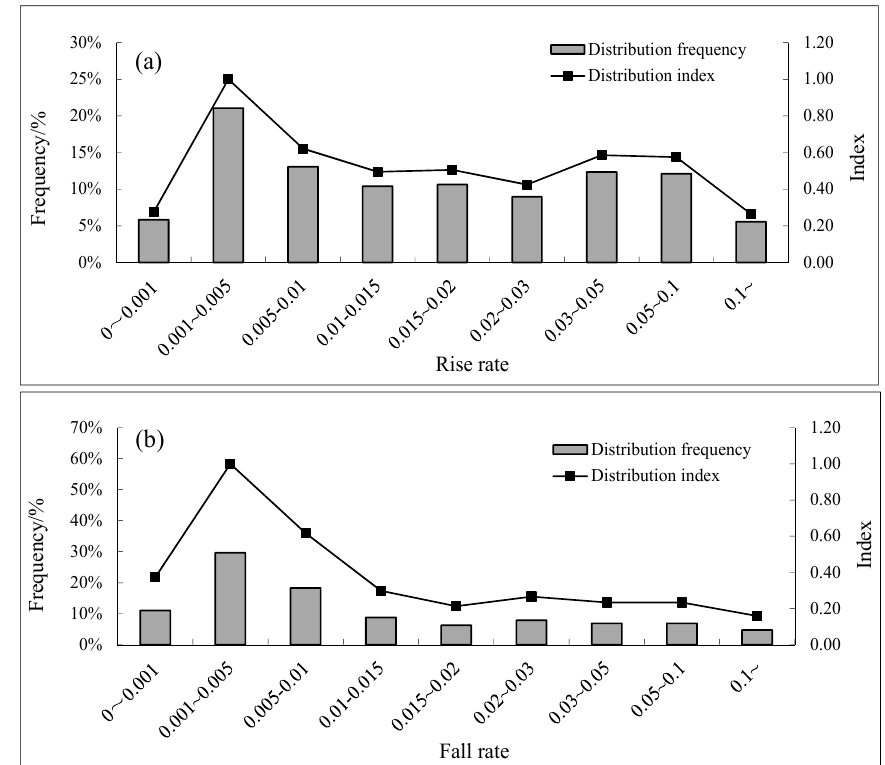
Figure 4. Distribution map of the rising rate ( a ) and falling rate ( b ).